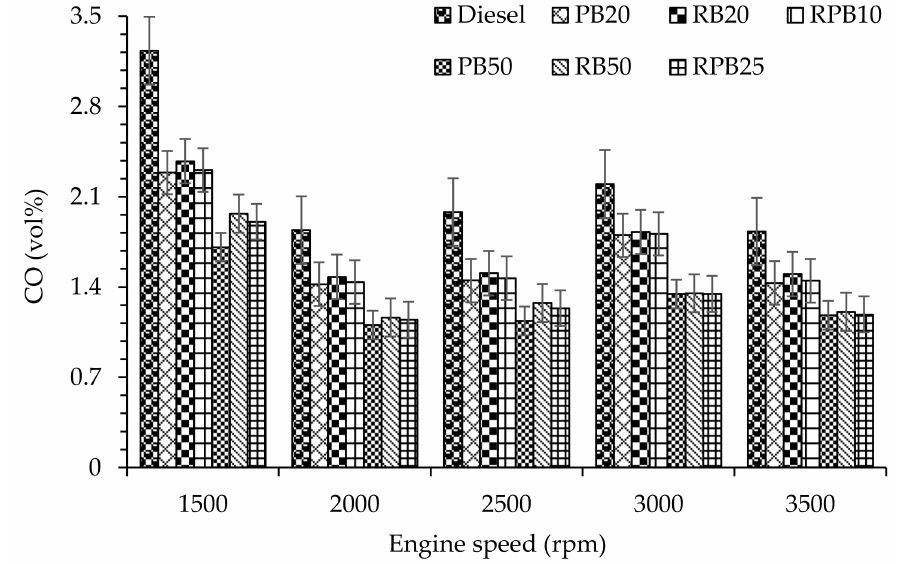
Figure 6. Variation of CO with respect to engine